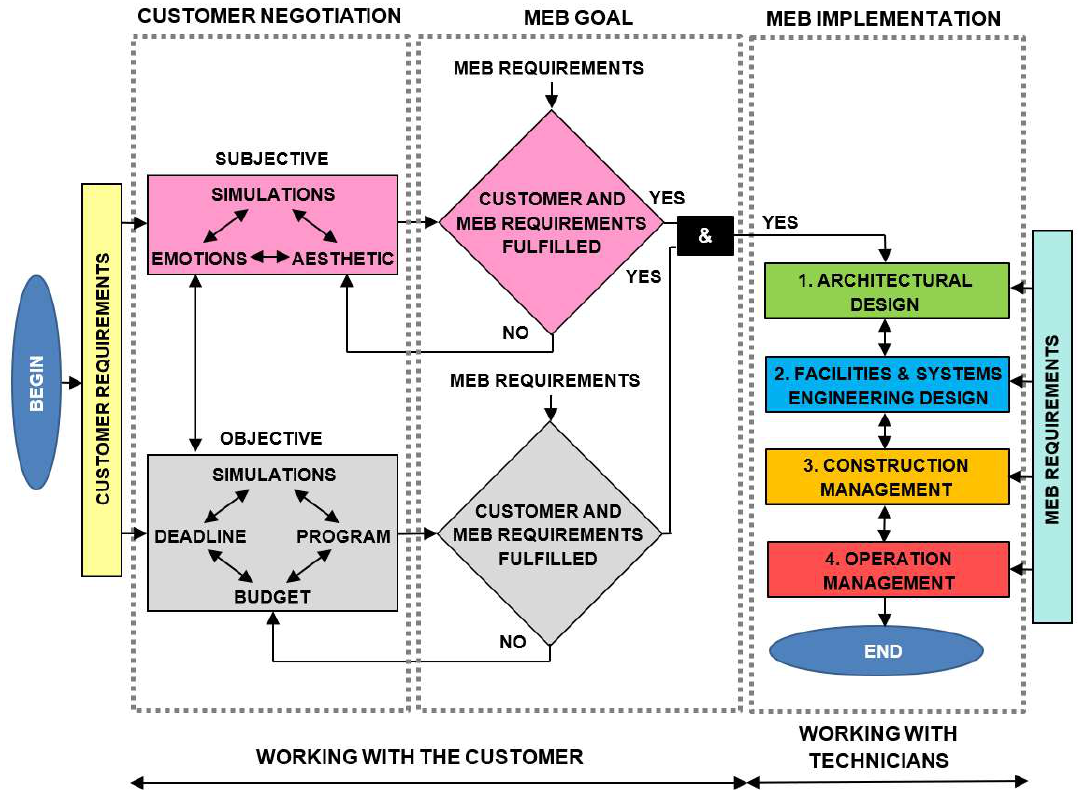
Figure 6. The University of Huelva minimum energy building (uhuMEB) methodology: general The University of Huelva minimum energy building (uhuMEB) methodology: algorithm. general